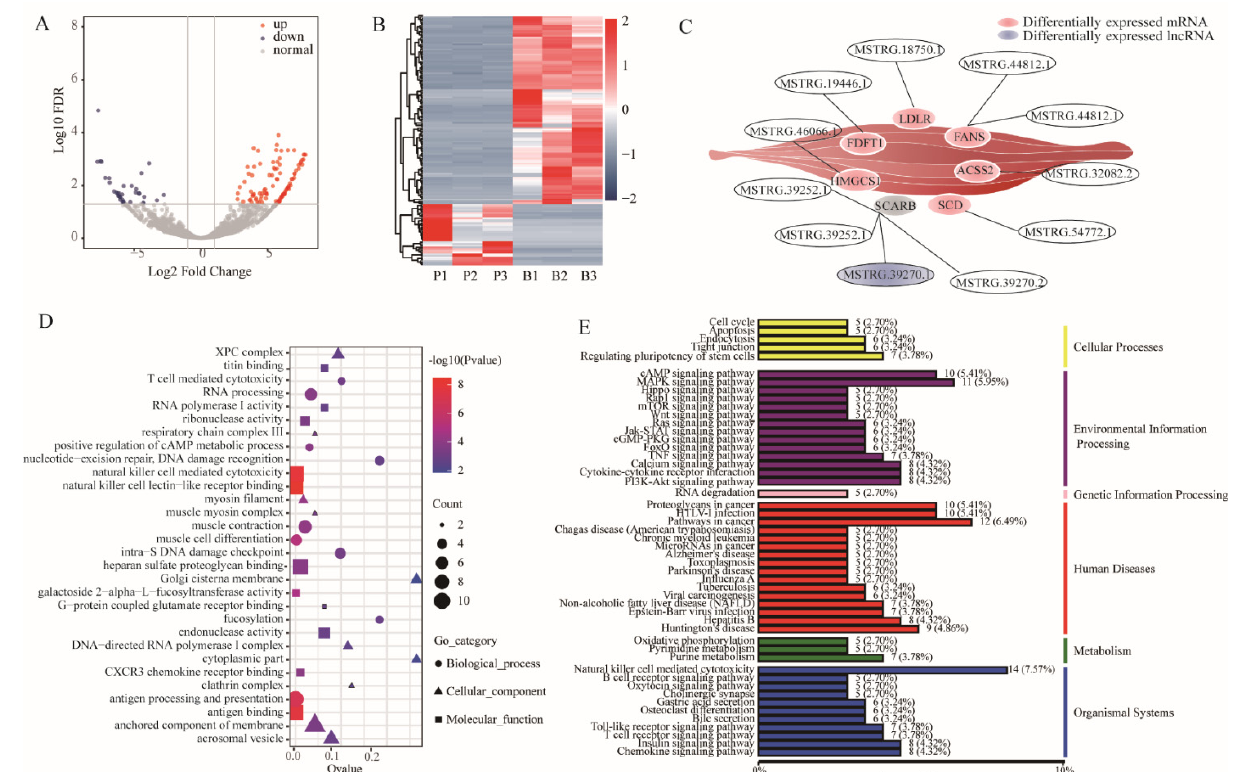
Figure 4. Differential expression and enrichment analysis of lncRNAs. ( A ) Differentially expressed lncRNAs in the muscles. ( B ) Cluster diagram of differentially expressed lncRNA. ( C ) Relationship between lncRNAs and the target genes. ( D ) GO analysis of biological process, molecular function and cell components of differentially expressed lncRNA CIS target genes among samples. ( E ) Classification of differentially expressed lncRNA CIS target gene KEGG.